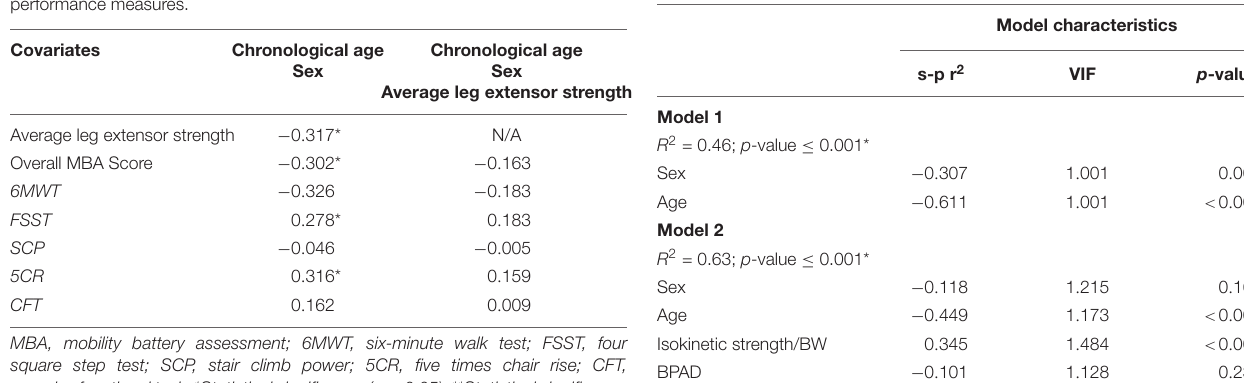
TABLE 5 | Regression model summary for the mobility battery assessment (MBA)